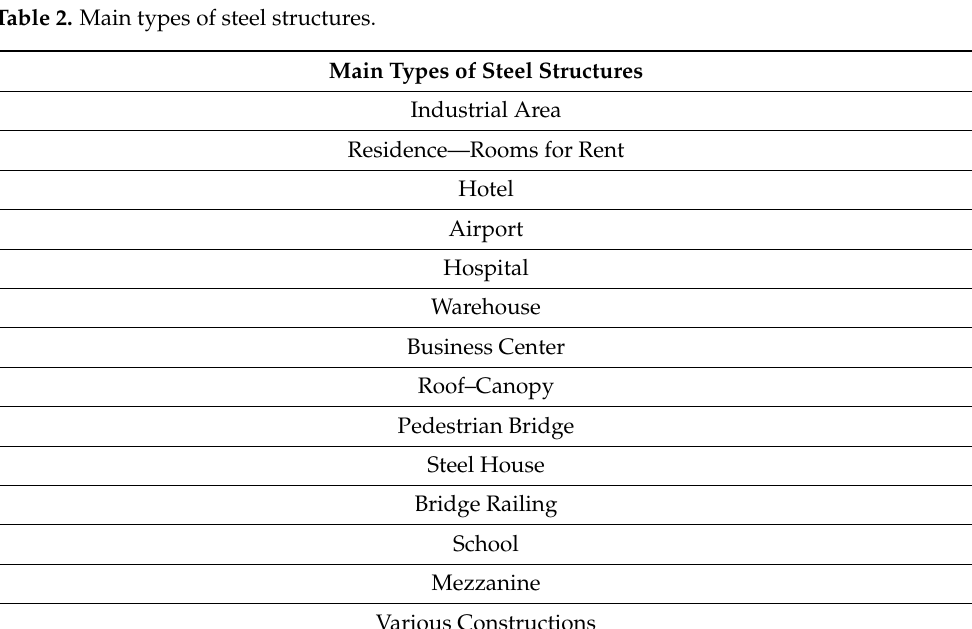
Table 2. Main types of steel